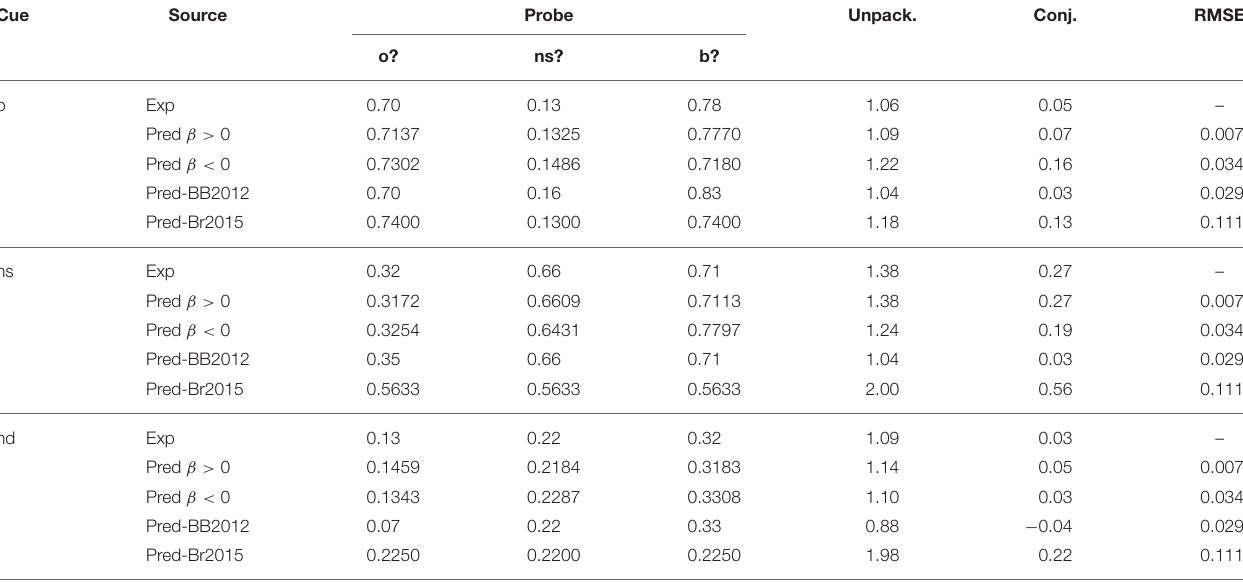
TABLE 1 | EOD-disjunction fallacy: Experimental and predicted acceptance probabilities by probe and cue in item false memory paradigm - immediate test [9]. Cue Source Probe Unpack.